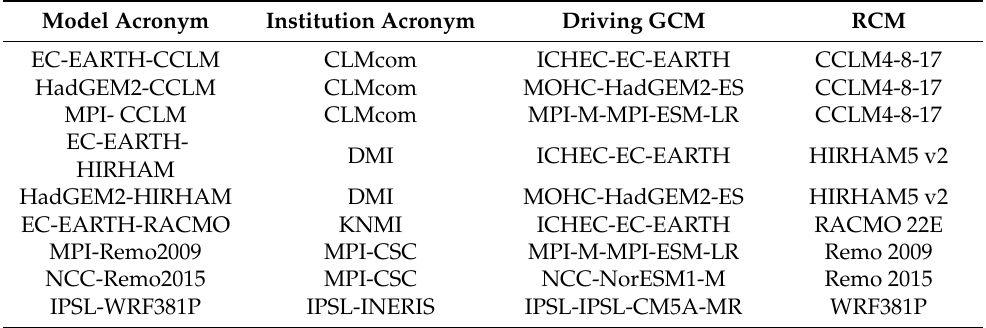
Table 1. Description of the main characteristics of the of the members of climate model ensemble used in the study. Data are provided for the historical, RCP4.5 and RCP8.5 experiment by the following Institutions: the Climate Limited-area Modeling Community (CLMcom), the Danish Meteorological Institute (DMI), Royal Netherlands Meteorological Institute (KNMI), the Max Planck Institute (MPI- CSC) and the Laboratoire des Sciences du Climat et de l’Environnement—Institute Pierre Simon Laplace